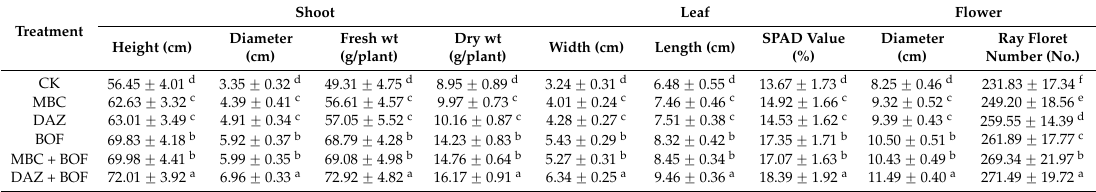
Table 1. The effect of the various soil treatments on the growth of chrysanthemum *.